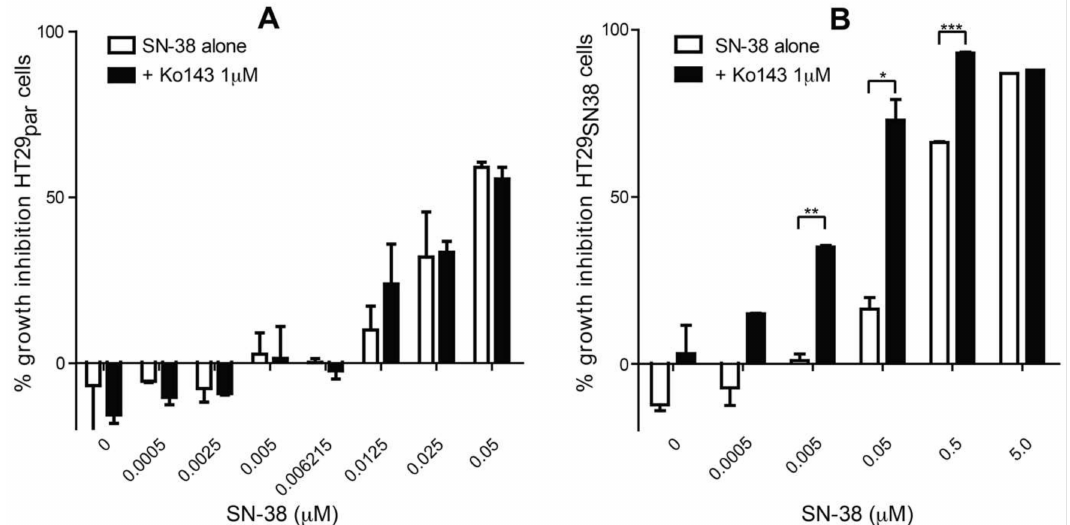
Figure 1. SN-38 dose–response experiments on HT29 parental (HT29 par , (( A ) and HT29 SN-38 resistant (HT29 SN38 , (( B ) cell lines. Growth inhibition is expressed as percentage relative to untreated control. Error bars indicate SD determined on the basis of n = 2. * p ≤ 0.05, ** p ≤ 0.01, *** p ≤